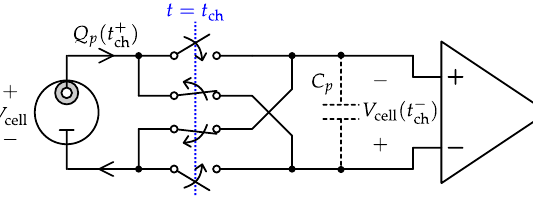
Figure 9. Potentiometric cell loading during transition of the input chopper